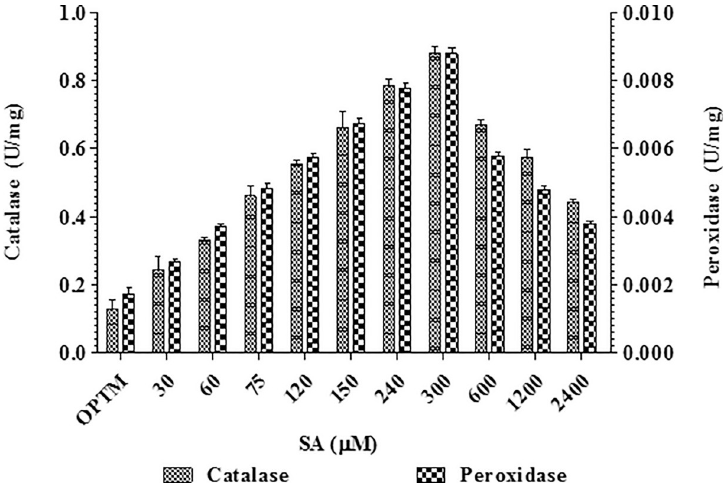
Fig 4. Effect of different concentrations of SA on catalase and peroxidase activity by P . microspora .